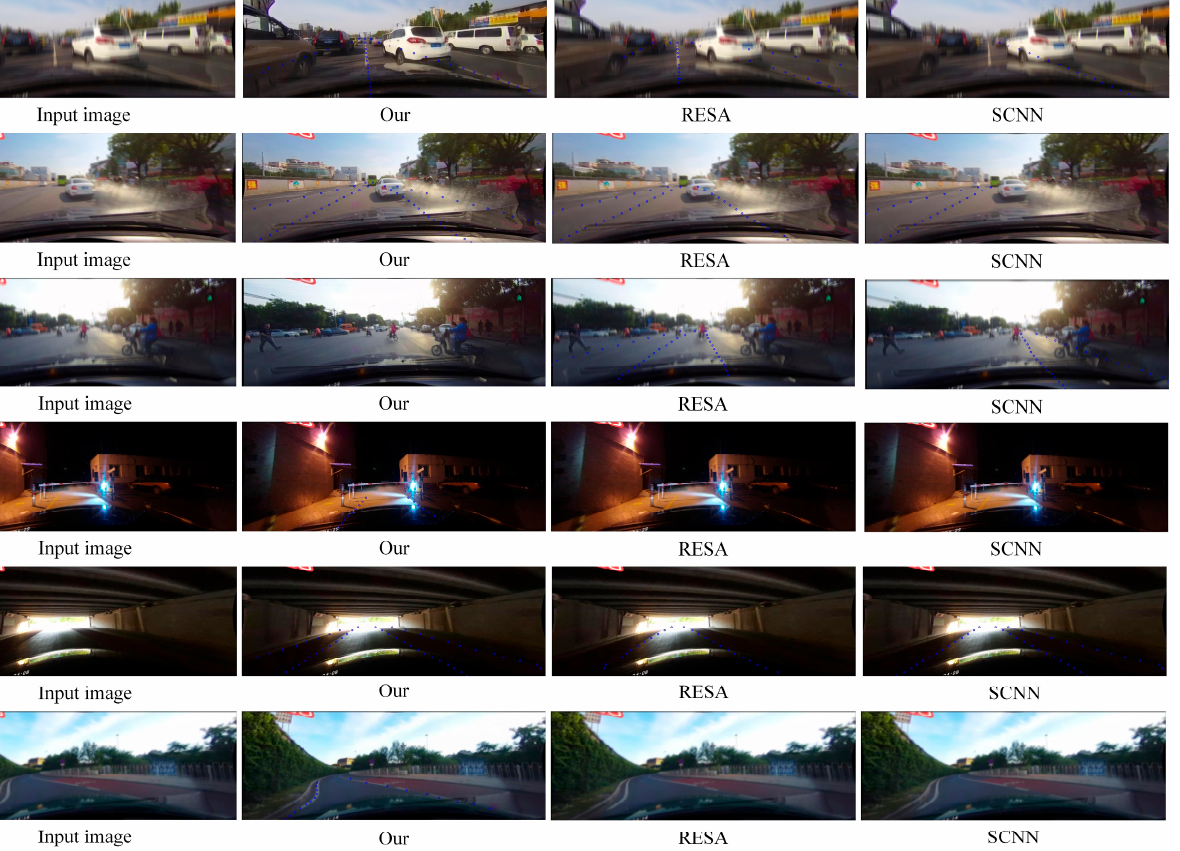
Figure 9. Visualization results of different algorithms on the blurred CULane testset.